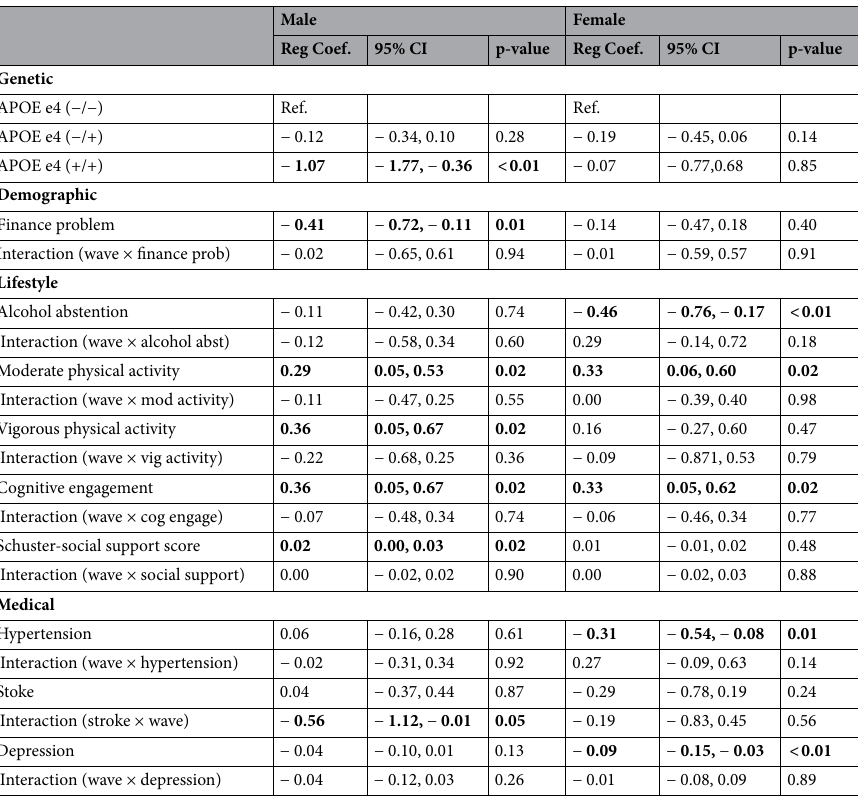
Table 4. Sex specific effects of risk factors on memory, and risk factor-by-wave interaction effects on memory decline (60 s cohort). Bold values indicate